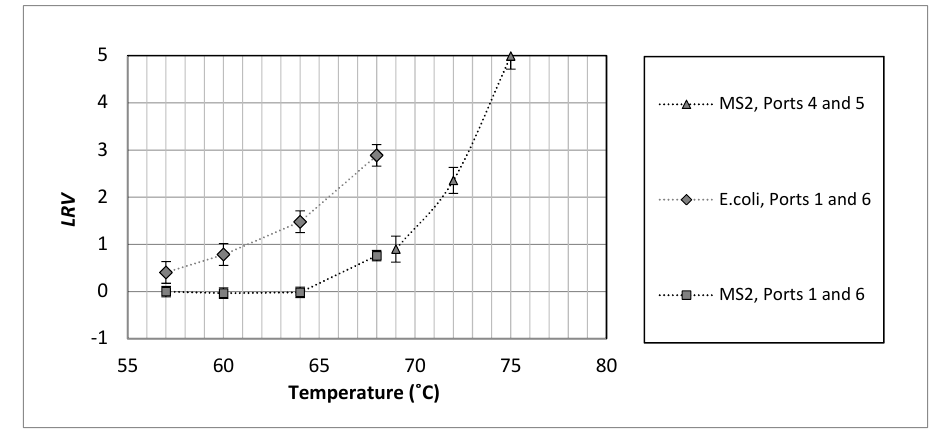
Figure 3. Comparison of disinfection performance at high flow rate, ~1,100 L/min) for the entire plant (Ports 1 and 6, added MS2 and native E. coli , 254 s contact time) with the disinfection achieved in the contact chamber (between Ports 4 and 5, added MS2 phage, 30 s contact time), error bars represent one average standard deviation. See Figure 1d for port locations.